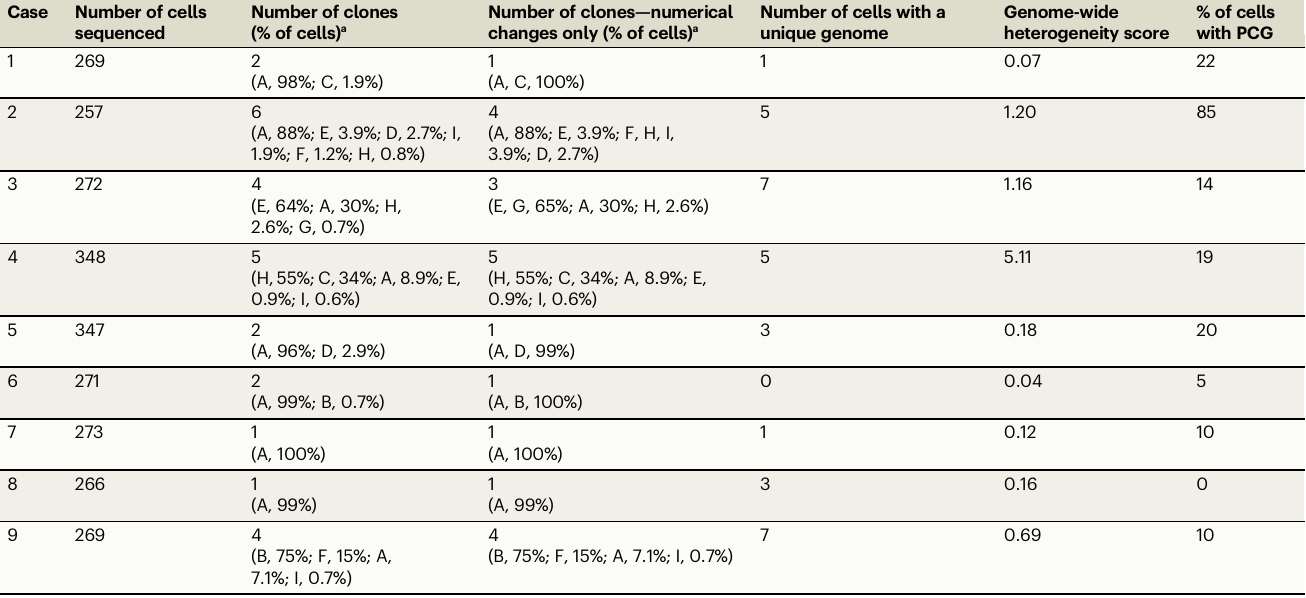
Table 1 | Genetic heterogeneity in nine high hyperdiploid childhood acute lymphoblastic leukaemia cases based on single cell whole genome sequencing Case Number of cells Number of clones Number of clones — numerical sequenced (% of cells) a changes only (% of cells) a